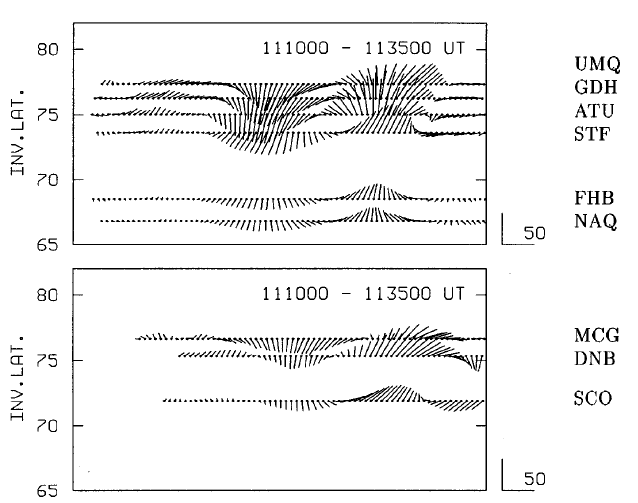
Fig. 3. Time series of equivalent convection vectors (in units of nT) for the interval 1110–1135 UT on July 29. 1991. The top frame display the data of the West Greenland chain of stations (IAGA codes right , and Invariant Latitude left ) and the bottom frame is for the East Greenland stations. The displacements between the starting points reflect the distribution of the stations in MLT, 20 sec (cid:25) 0.2 hours of MLT, that is assuming a velocity of 4–6